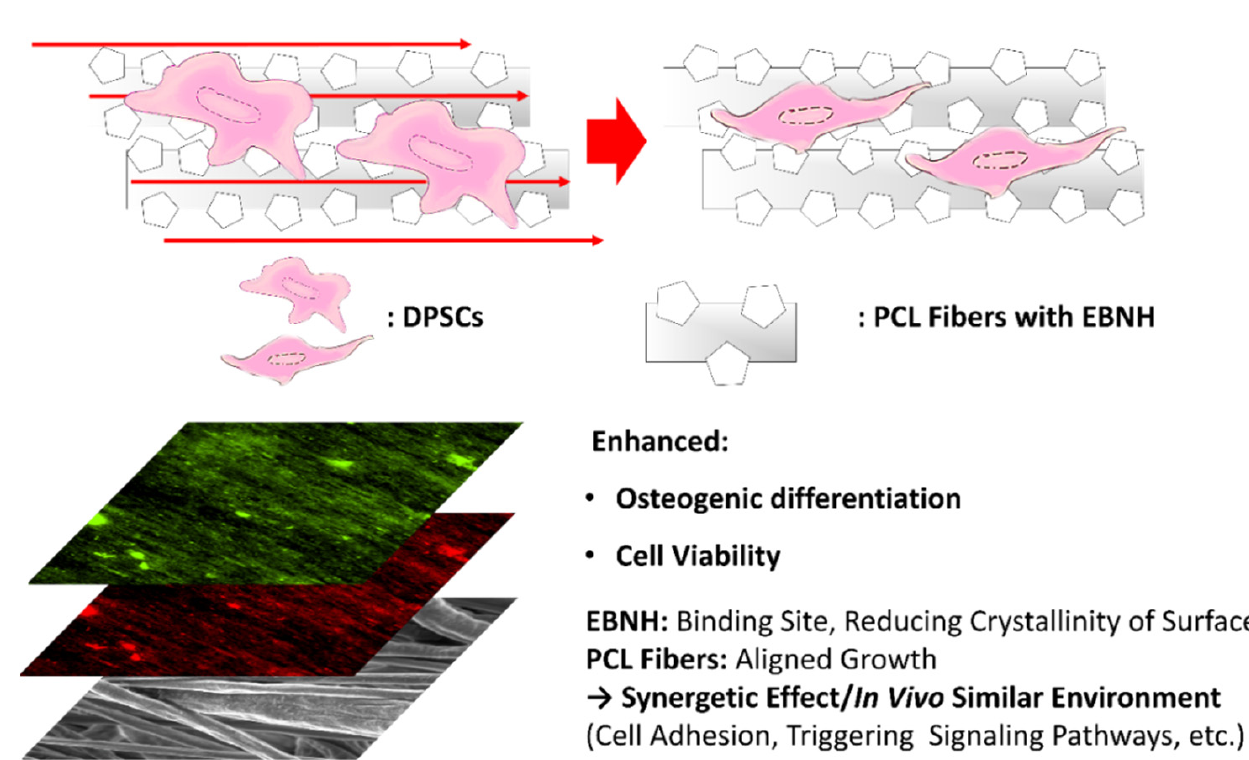
Figure 4. Overall summary of the study. EBNH-RBs enhanced osteogenic differentiation and cell viability, possibly by the synergetic effect of EBNH, reducing crystallinity and alignment of PCL nanofibers combined with EBNH to induce a similar in vivo environment.